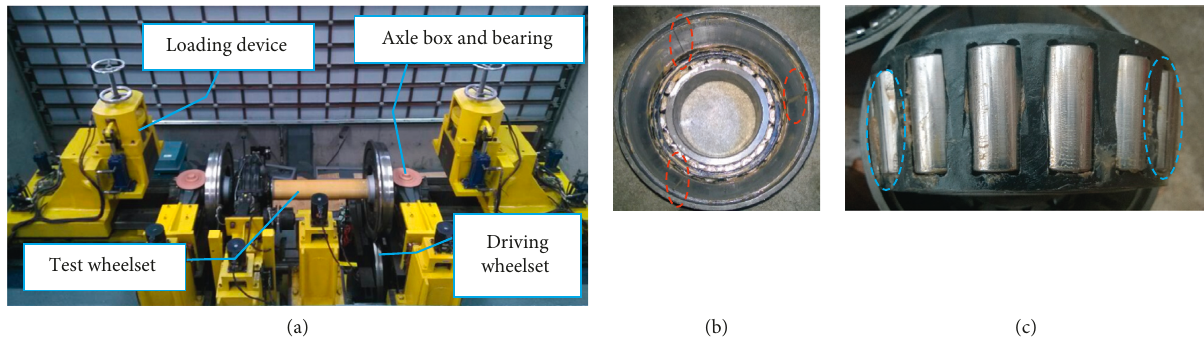
Figure 9: Fault test rig and bearing defects: (a) fault test rig; (b) three defects on the surface of outer race; (c) two defects on the surface of the rolling